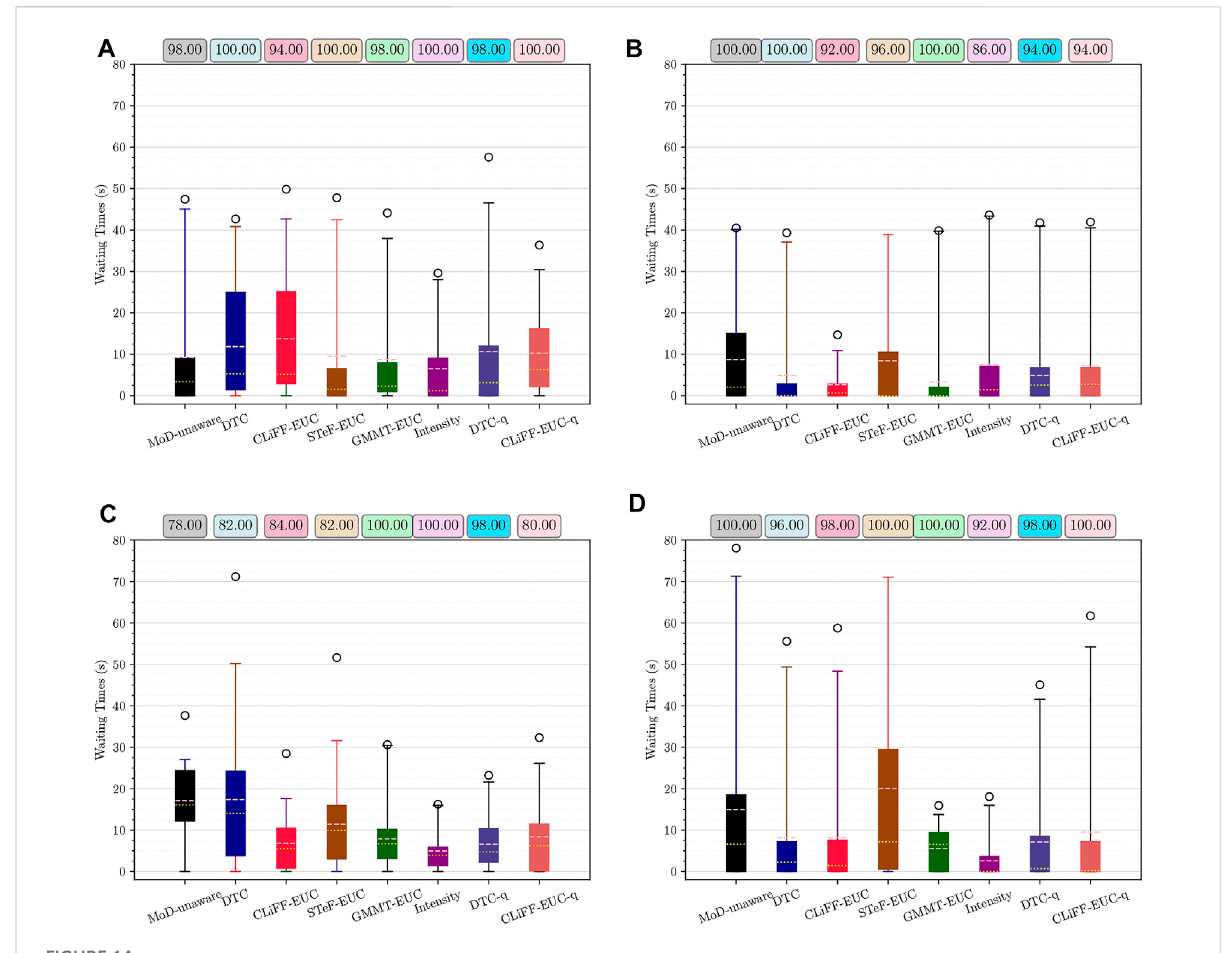
FIGURE 14 Waiting timeand success ratefor Scenario1 – 4 (A – D) respectively, from theATCenvironment.Means areshown inpinkand medians inyellow. Whiskers extend from 0 to